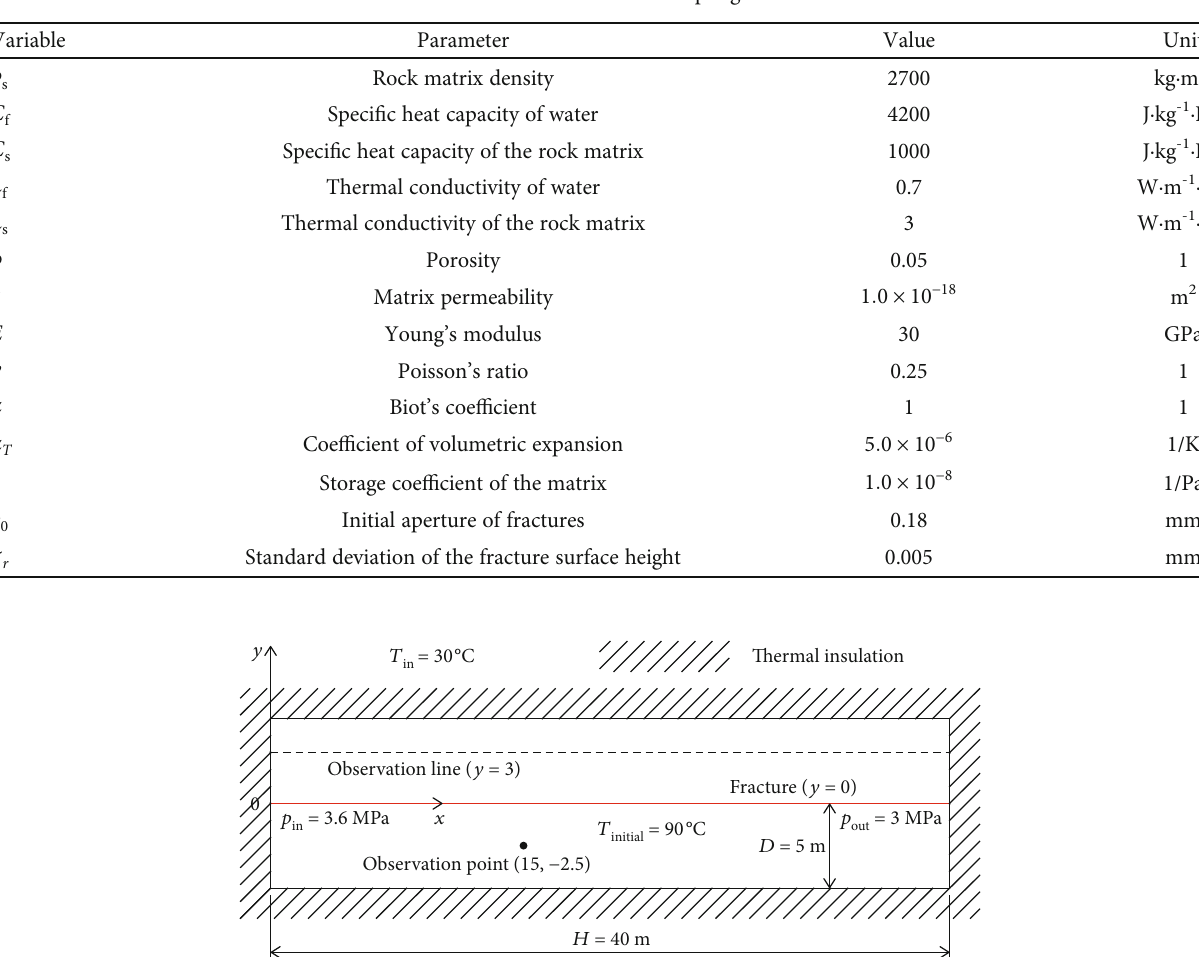
Table 2: Parameters of the coupling model.